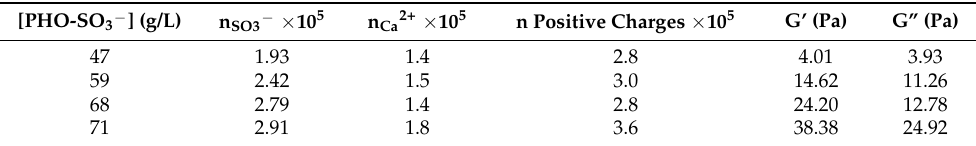
Table 1. Influence of PHO-SO 3 − concentration on gel mechanical properties of PHOSO 3 − /Ca 2+ networks at 10 Hz.